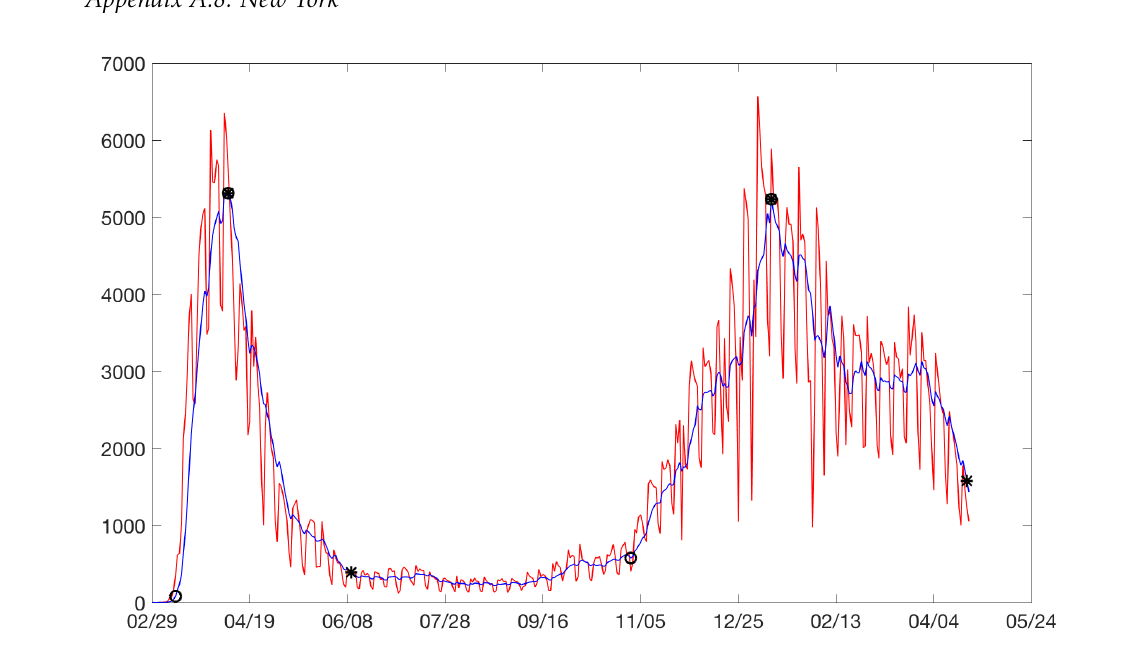
Figure A20. New York: on the horizontal axis is the date in days and on the vertical axis are the daily cases.